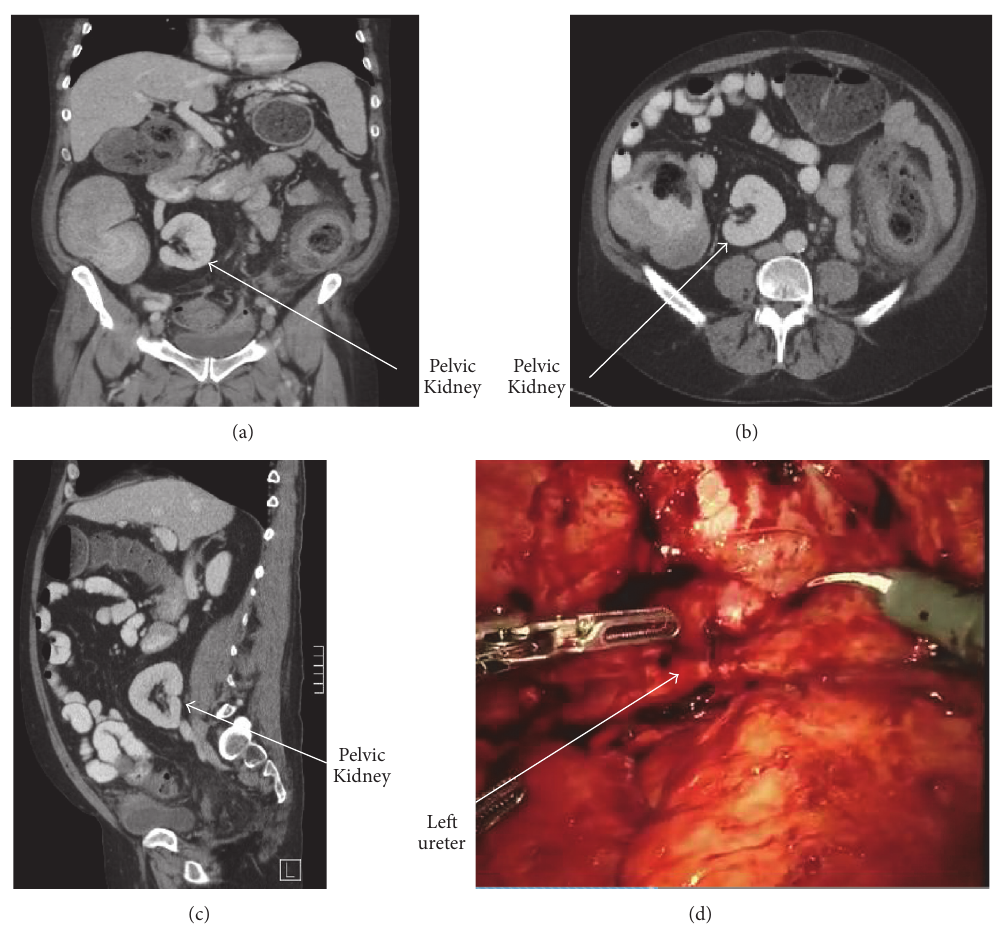
Figure 1: (a) Coronal view of unilateral crossed left renal ectopia without fusion to the right kidney. (b) Axial view of unilateral crossed left renal ectopia without fusion to the right kidney. (c) Sagittal view of unilateral crossed left renal ectopia without fusion to the right kidney. (d) Robotic view of dense adhesions to the left ureter in presacral